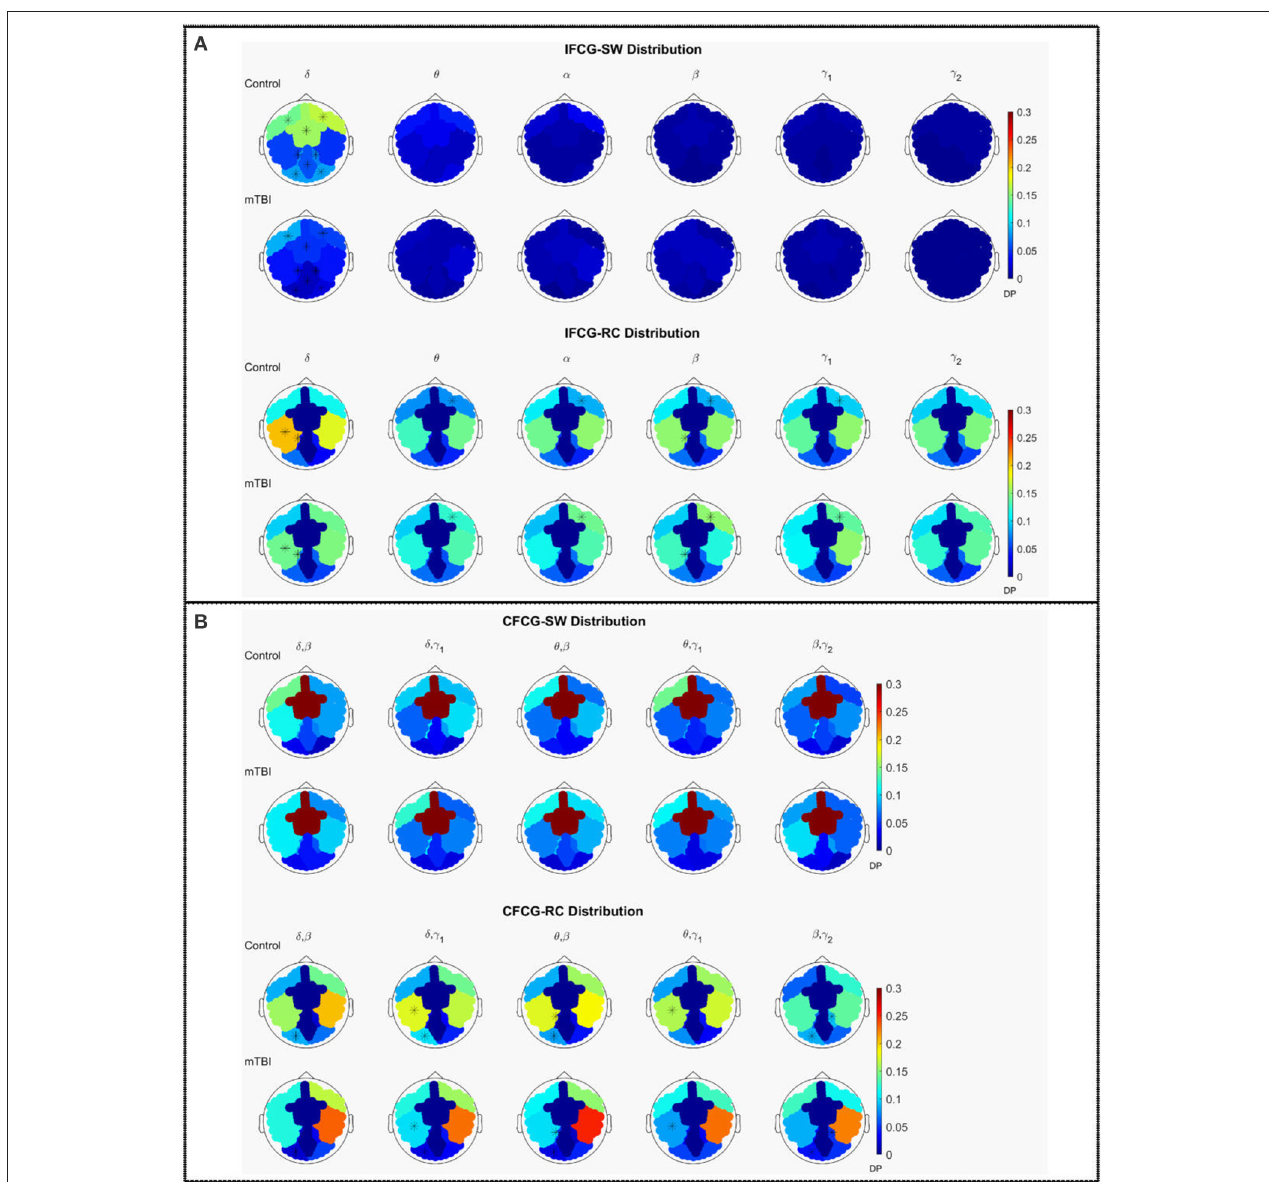
FIGURE 2 | Average distribution of SW and RC nodes on the head surface for control and mTBI subjects showing (A) intra-frequency (MI-IFCG) and (B) inter-frequency (CFC-CFCG) connections for each FCG type. In (B) only the top five cross-frequency pairs with the highest classification accuracy are shown. The colorbar is common type of FCG and network organization represents discrete probability